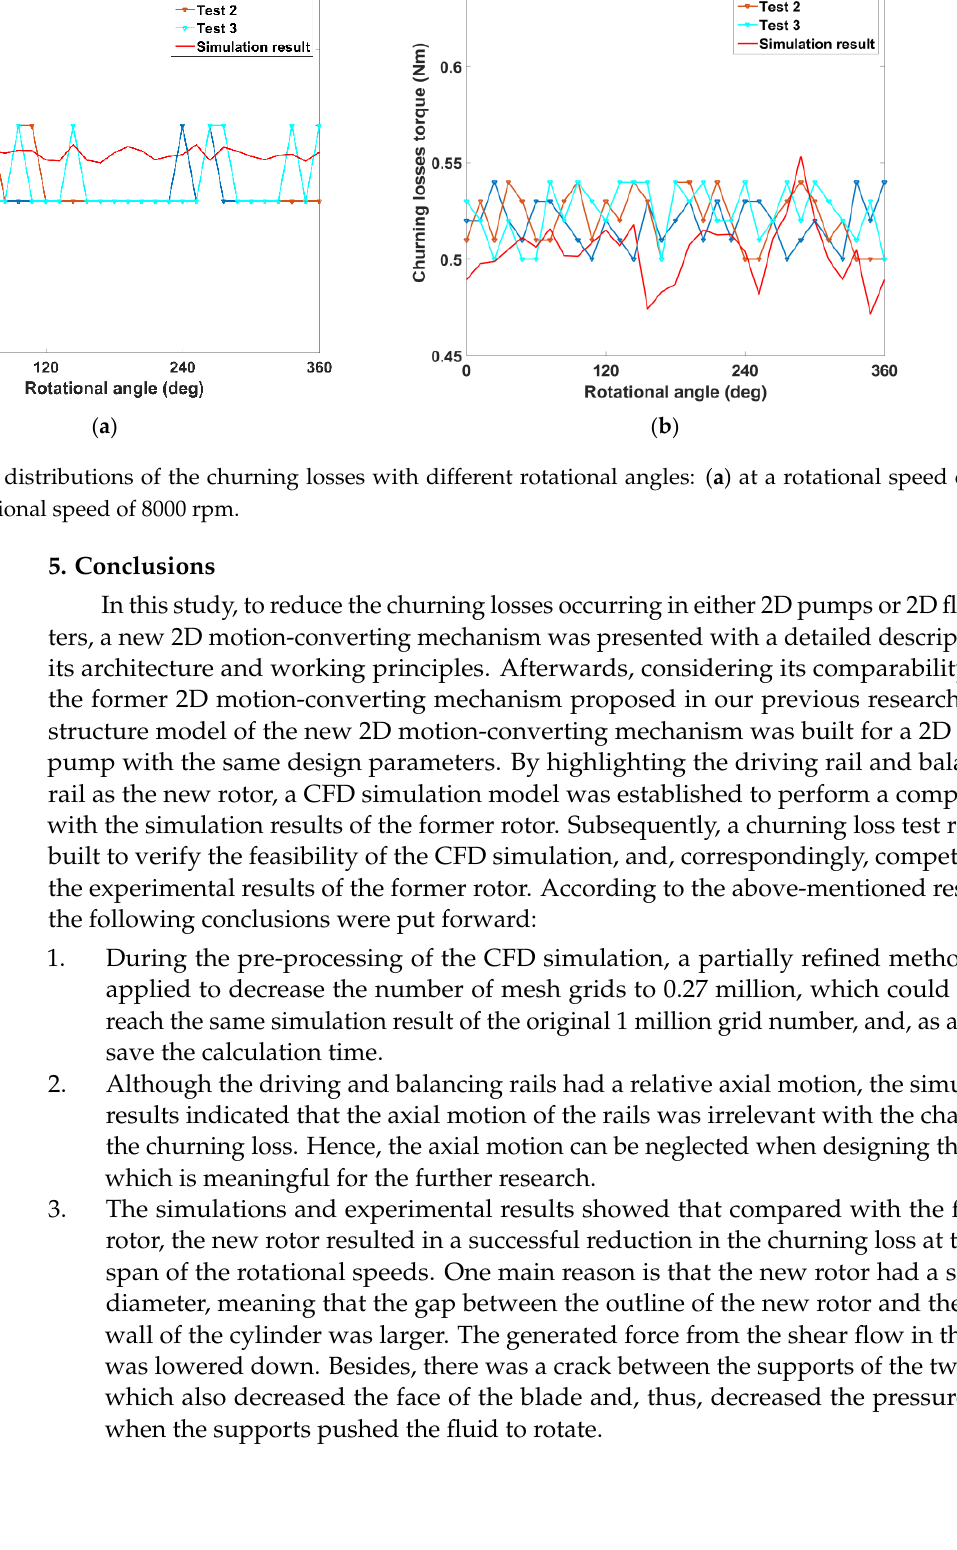
Figure 13. The churning loss torques of the new rotor and the former rotor.